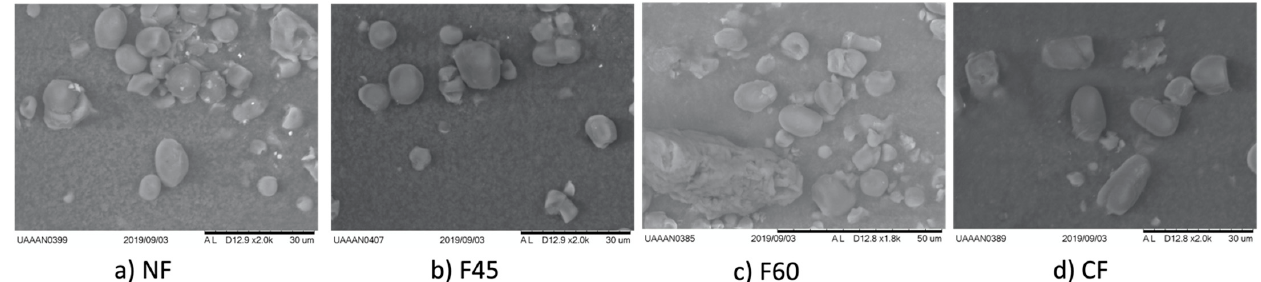
Figure 2. Scanning electron micrographs (magnification at 2000) of ( a ) NF, naturally sun-dried flour, ◦ C, ( c ) F60, flour dried at 60 ◦ C ( d ) CF, commercial flour. ( b ) F45, flour dried at 45 °C, ( c ) F60, flour dried at 60 °C ( d ) CF, commercial flour. ( b ) F45, flour dried at 45